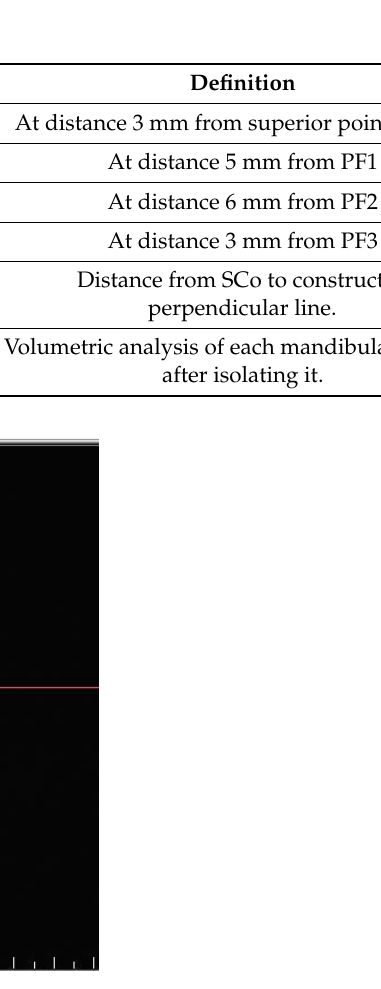
Figure 4. Joint space measurements: ( 1 ) superior joint space; ( 2 ) posterior joint space; and ( 3 ) anterior joint space.